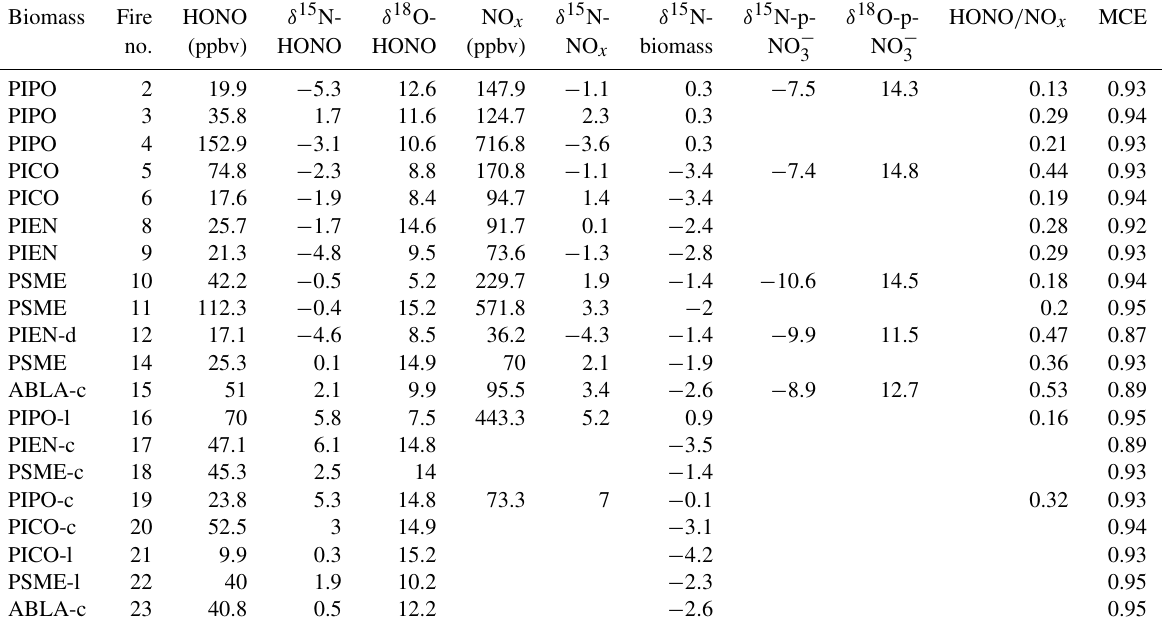
Table 1. Concentration (mean, derived from solution concentration and flow rate) and N isotopic composition for various biomass burning experiments (all δ denotations: ‰). MCE values are extracted from the NOAA FIREX fire archive. Note: fire nos. 1, 7, and 13 were missing due to technical issues; NO x results are only shown when the blank-to-sample ratio is <70%. Biomass acronyms are defined in Sect. 2.1; d – duff, c – canopy, l –